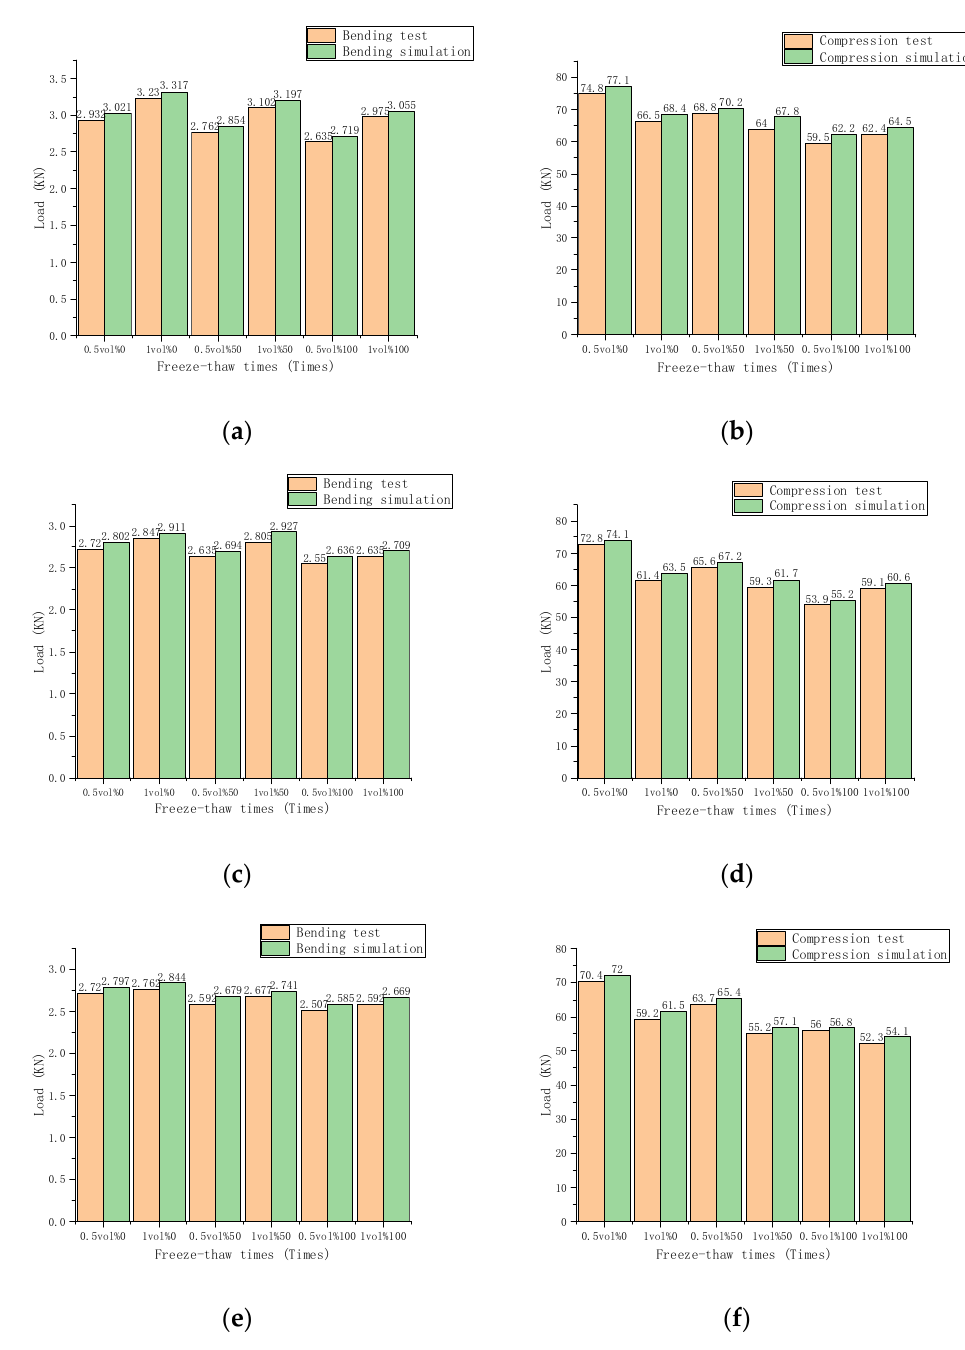
Figure 15. Comparison of fiber load: ( a ) Comparison of carbon fiber bending test; ( b ) Comparison of carbon fiber compression test; ( c ) Comparison of glass fiber bending resistance test; ( d ) Comparison of glass fiber compression test; ( e ) Comparison of PVA fiber bending resistance test; ( f ) Comparison of PVA fiber compression test.